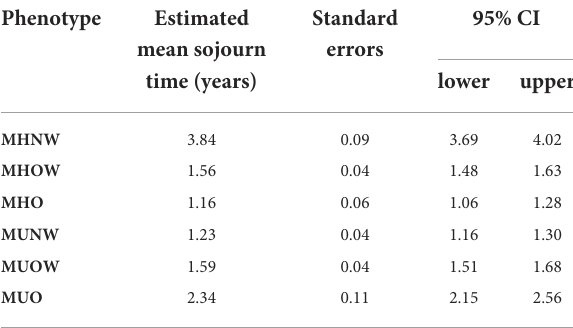
TABLE 4 Estimated mean sojourn time in each